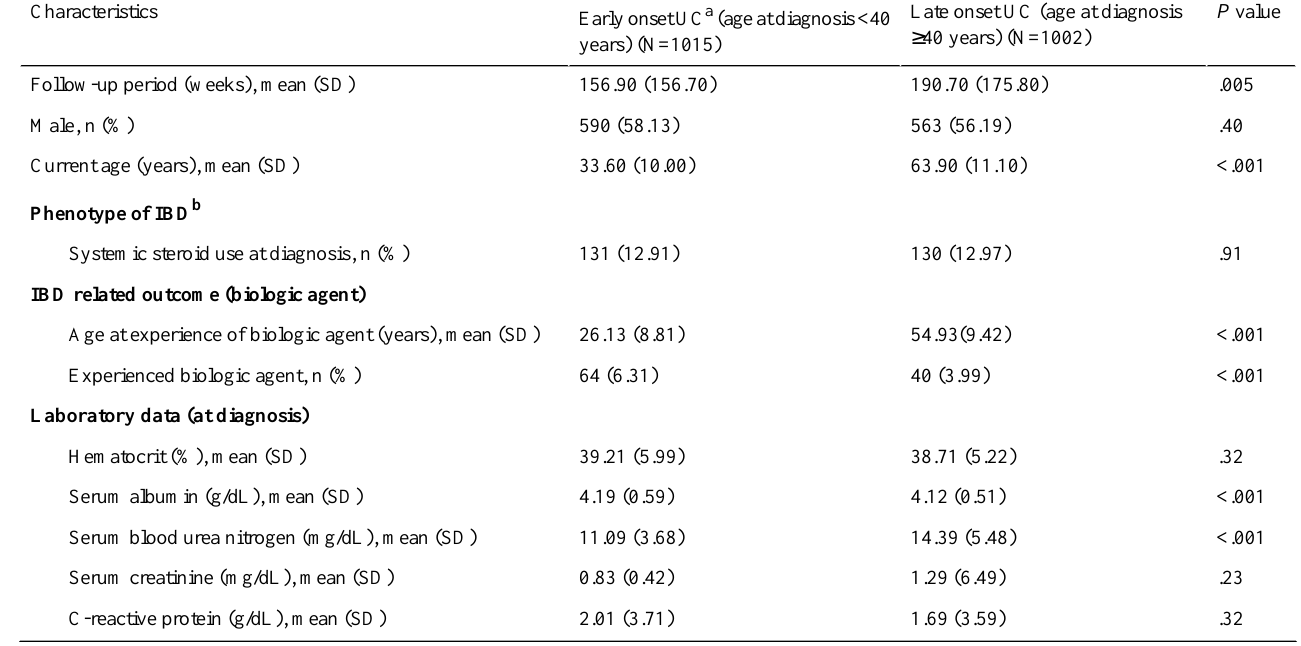
Table 2. Univariate analysis biologic agent experience between early onset and late onset groups in ulcerative colitis (N=2017).